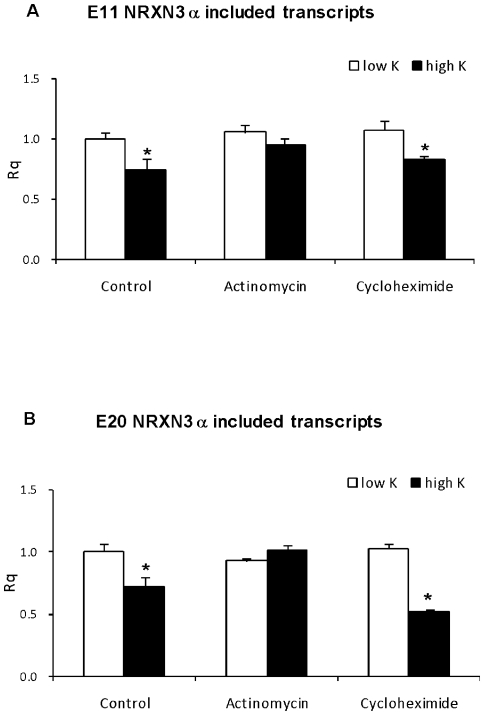
The depolarization-induced repression of NRXN3α E11 and E20 splicing depends on RNA synthesis but not protein synthesis.Rat cortical neurons grown in culture for 14 days were incubated with 5 and 50 mM KCl for 6 hours in the absence (control) or presence of actinomycin (10 ug/ml), cycloheximide (10 ug/ml). Quantification of NRXN3α (A) E11 and (B) E20 included transcripts was performed by Real-time PCR RT-PCR. Rq values are mean +SEM from at least 3 experiments (* = P<0.05; t-test).